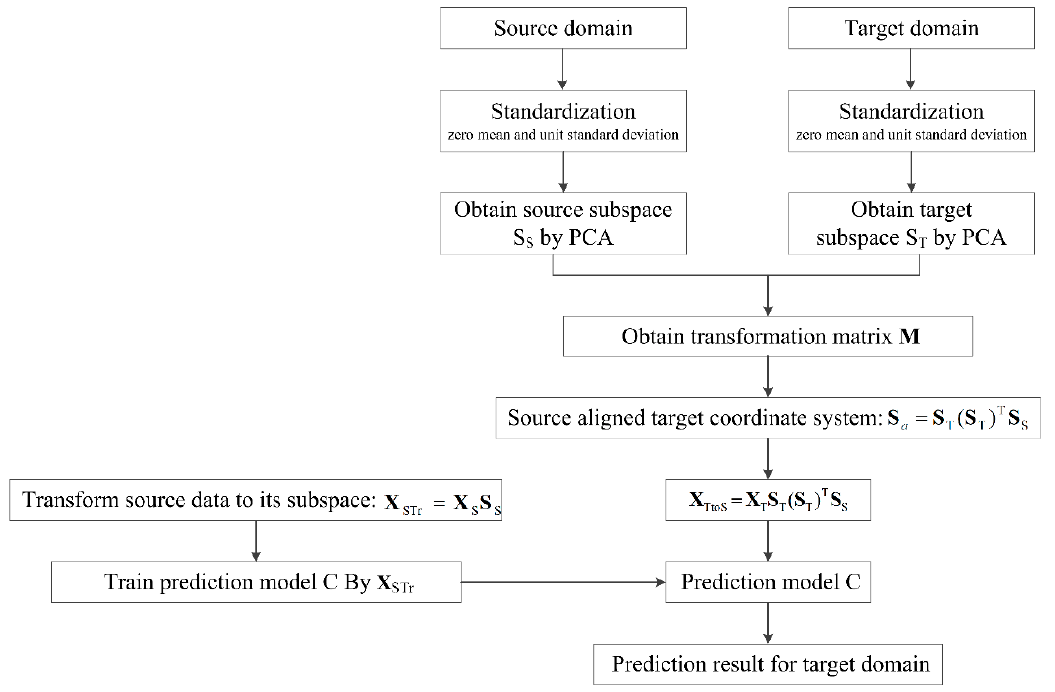
Figure 5. Flow chart of SAIS method.